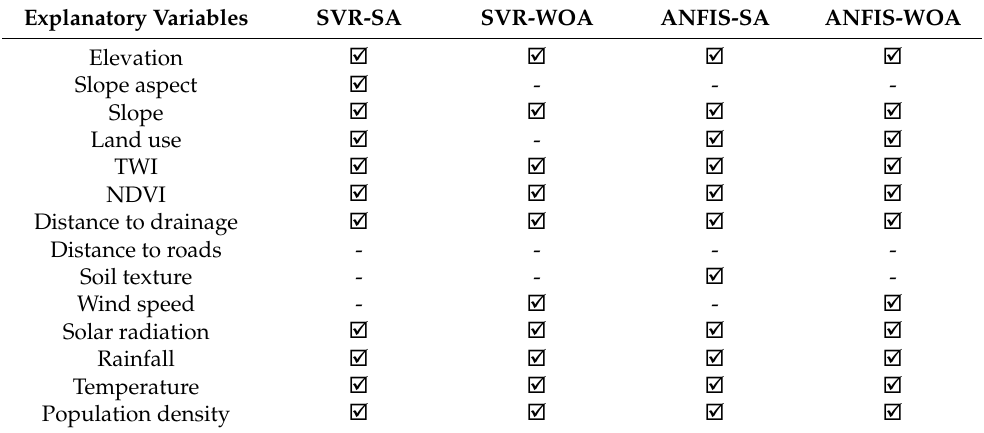
After the selection of the main factors, they were entered into the ANFIS and SVR models. As discussed earlier, SA and WOA were employed to determine the premise and consequent parameters in the ANFIS model, as well as the C and γ parameters in SVR. Figures 5 and 6 show the real and modeled values of the training and validation data in addition to the RMSE and MSE for the ANFIS-WOA and ANFIS-SA models. Accordingly, the ANFIS-WOA model had a smaller RMSE (0.317) in the training phase than the ANFIS- SA model (0.324). However, in the validation phase, the RMSE of the ANFIS-SA model (0.371) was slightly lower than that of the ANFIS-WOA (0.376).